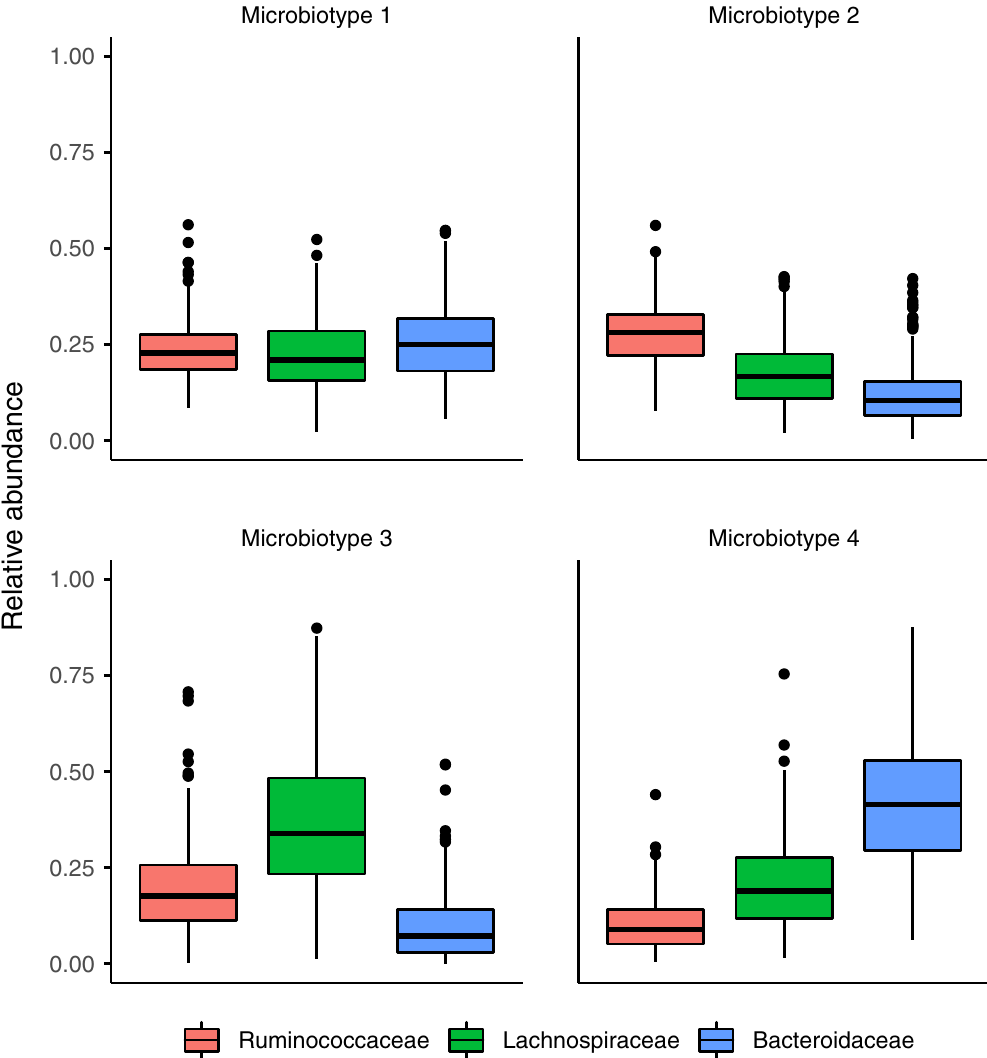
Figure 4. Abundance of the main families involved in the building of Microbiotypes. Boxplot representing the abundances of the Ruminococcaceae (red box), Lachnospiraceae (green box) and Bacteroidaceae (blue box) in the Microbiotype-1 ( A ), -2 ( B ), -3 ( C ) and -4 ( D ). The solid black lines indicate medians, and the lower and upper bounds of the box represent the 25 and 75% quartiles. Outliers are indicated as black circles and represent samples falling outside the 10 and 90%